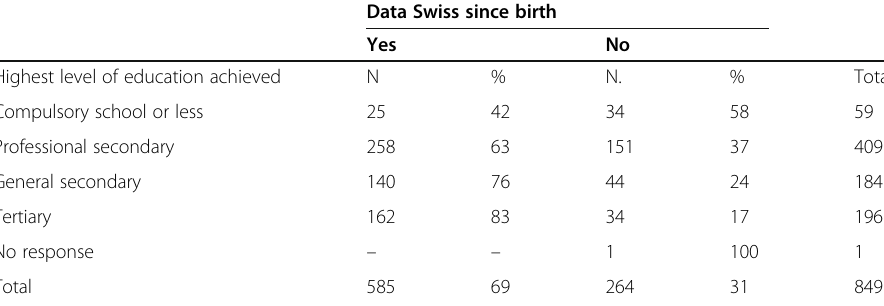
Data Swiss since birth Yes No